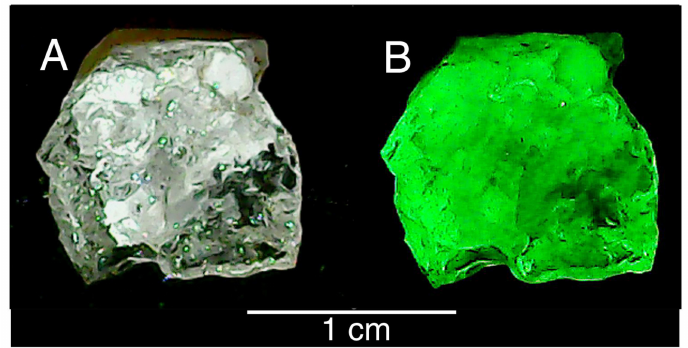
Figure 6. Opal-An (hyalite opal) from Zacatecas, Mexico. ( A ) Natural light. ( B ) Fluorescence at short-wave UV light (254 nm). Specimen provided by Jack